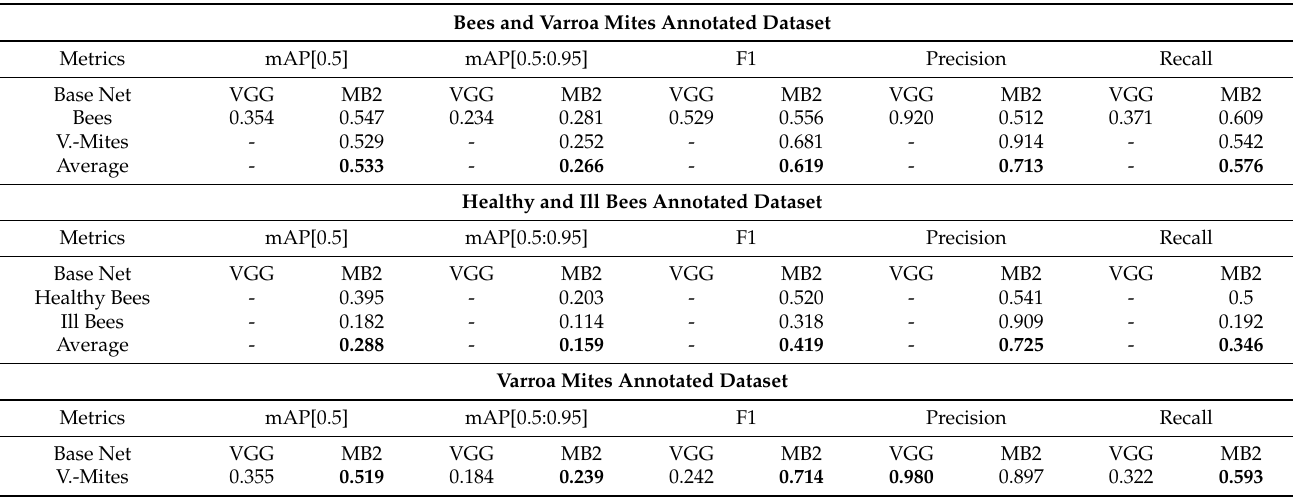
Table 7. Test score achieved by the SSD models on all datasets variants. The best results in V.-mite detection achieved by the SSD X model for the Healthy and Ill bees